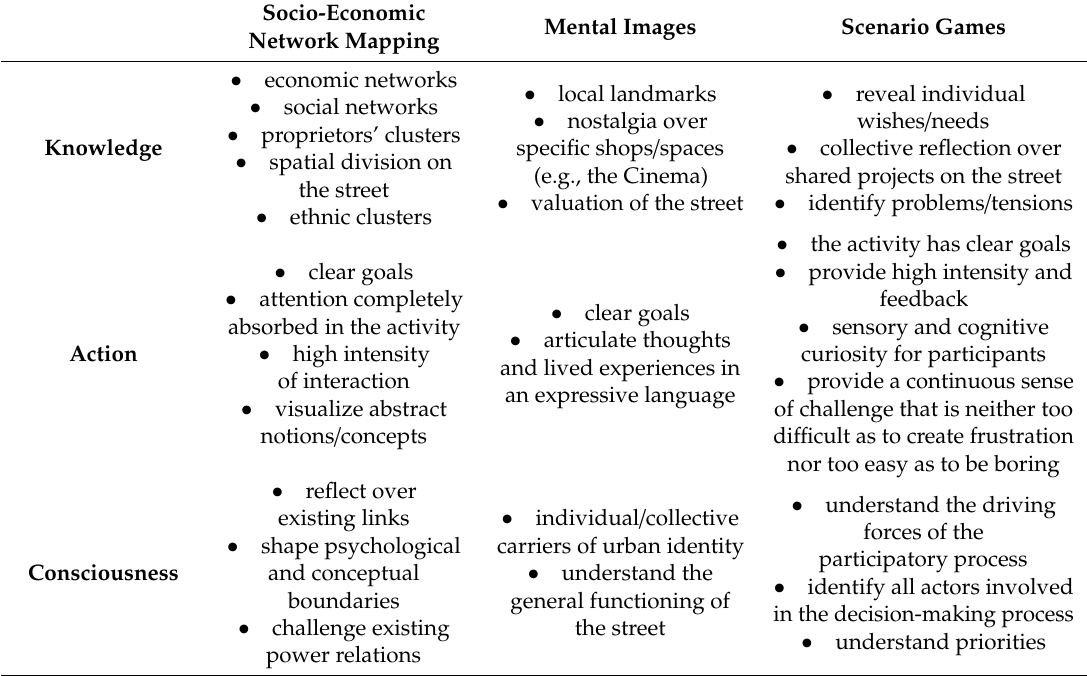
Table 2. Link between knowledge, action, consciousness and socio-economic network mapping, mental images and scenario